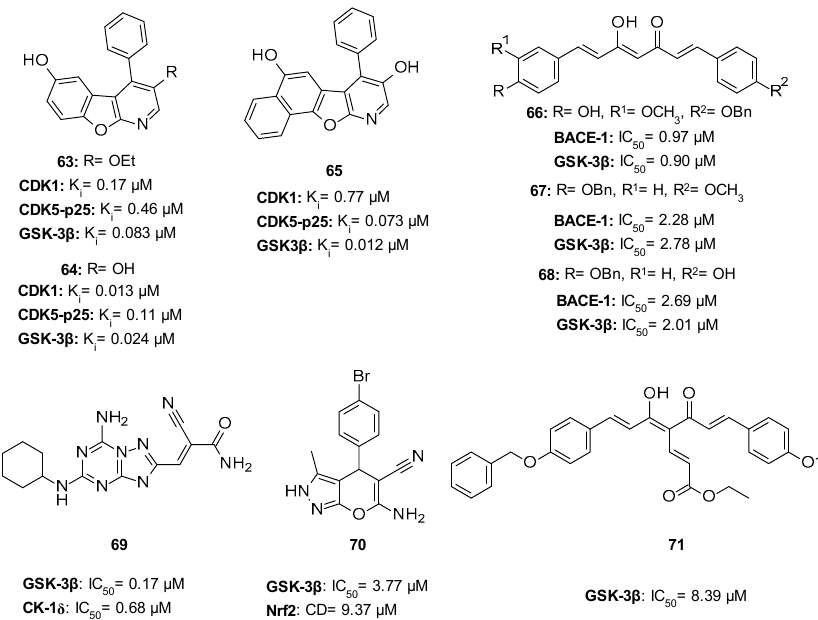
Figure 12. Chemical structures of multi-target GSK-3 β inhibitors.